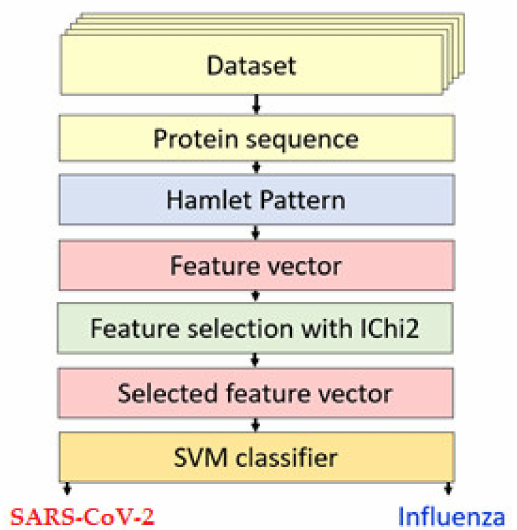
Figure 1. Schema of the proposed HamletPat-based model for binary classification of viral protein sequences.